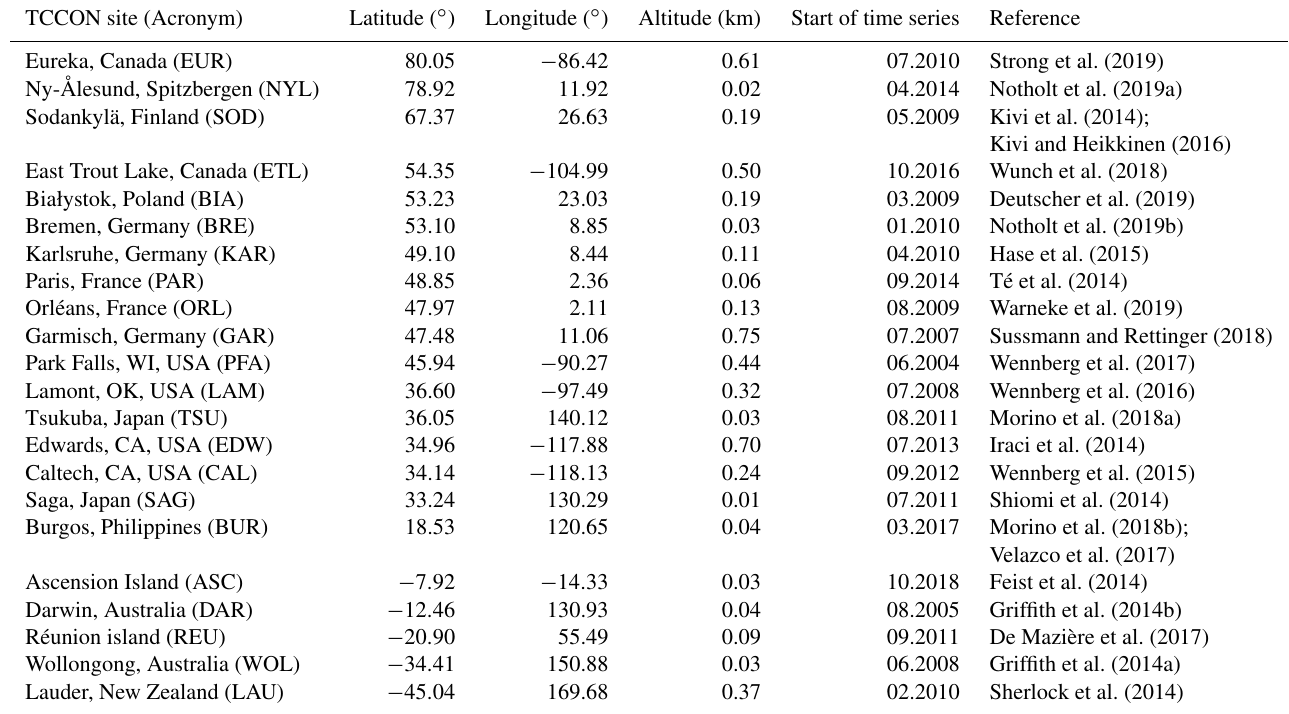
Table 3. TCCON sites used for the validation of the XCO 2 and XCH 4 satellite-derived data products. TCCON site